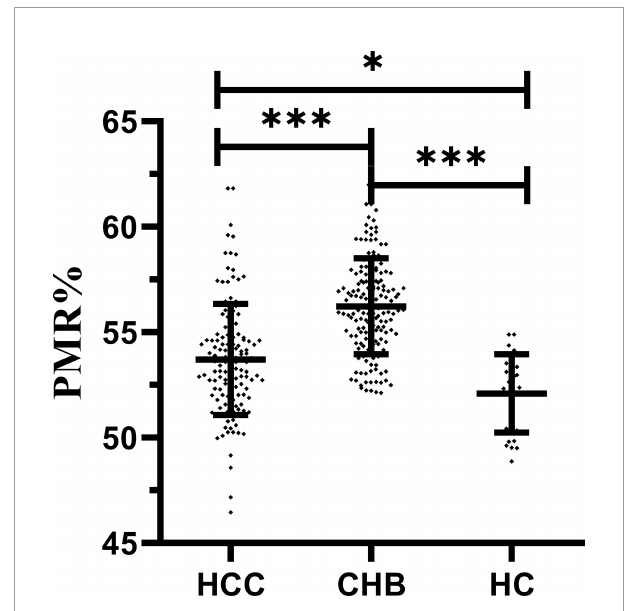
FIGURE 2 | IL-6 promoter methylation level in patients with HBV-associated HCC, CHB and HCs. The IL-6 methylation level was signi fi cantly lower in patients with HBV-associated HCC than in those with CHB (p < 0.001) but higher than that in HCs (p = 0.026). Meanwhile, methylation levels of the IL-6 promoter were signi fi cantly higher in CHB patients than in healthy controls (P < 0.001) ***p < 0.001, *p < 0.05.